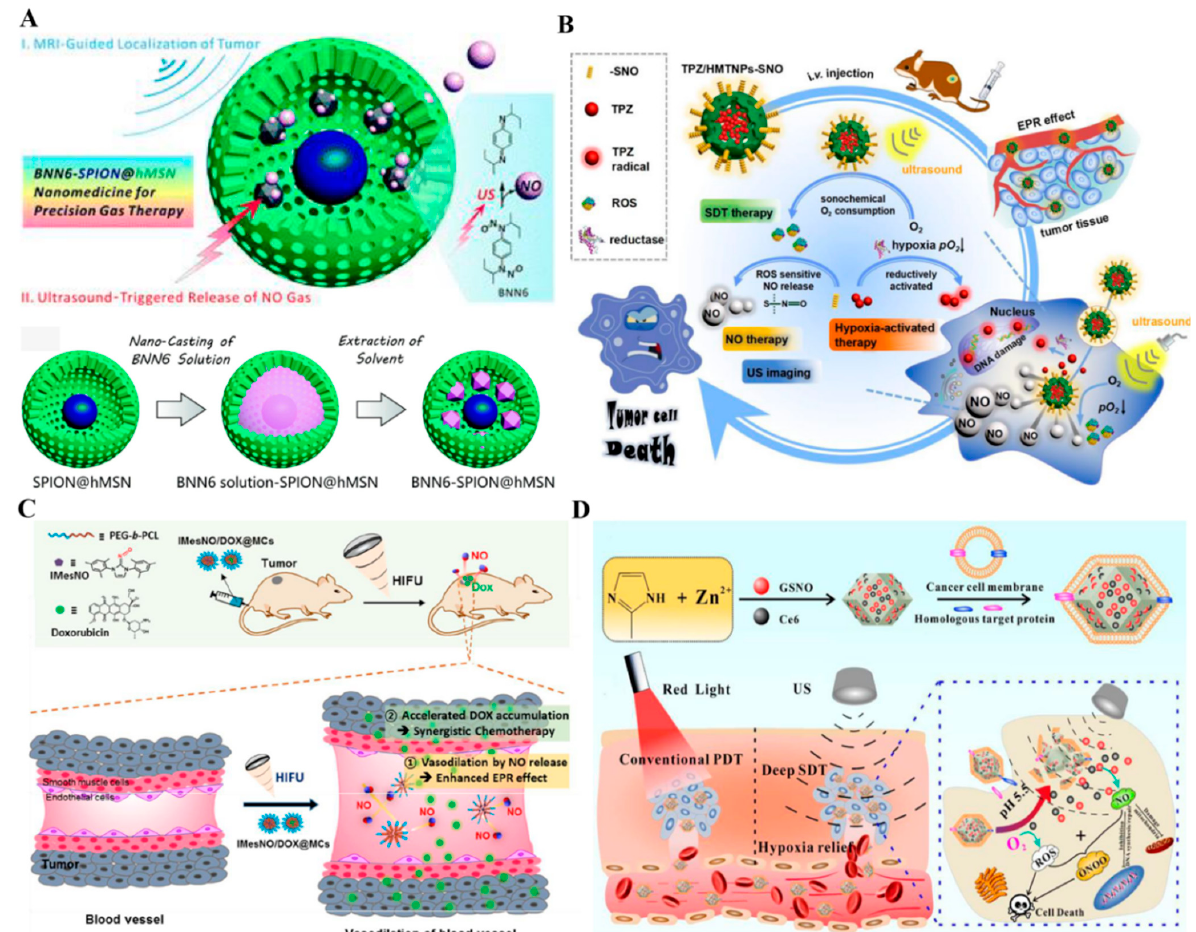
Figure 5. ( A ) Schematic diagram of the preparation of BNN6–SPION@hMSN which could achieve the controlled release of NO with ultrasound stimulation. Reproduced with permission from [88], Nanoscale, 2017; ( B ) schematic diagram of the therapeutic modes of TPZ/HMTNPs–SNO in cancer cells. Reproduced with permission from [89], Journal of Controlled Release, 2018; ( C ) Schematic diagram of the anti-tumor effect of nanomicelles IMesNO/DOX@MCs under HIFU irradiation. Reproduced with permission from [90], Biomaterials, 2019; ( D ) schematic diagram of the preparation of from [91], Biomaterials, 2019.